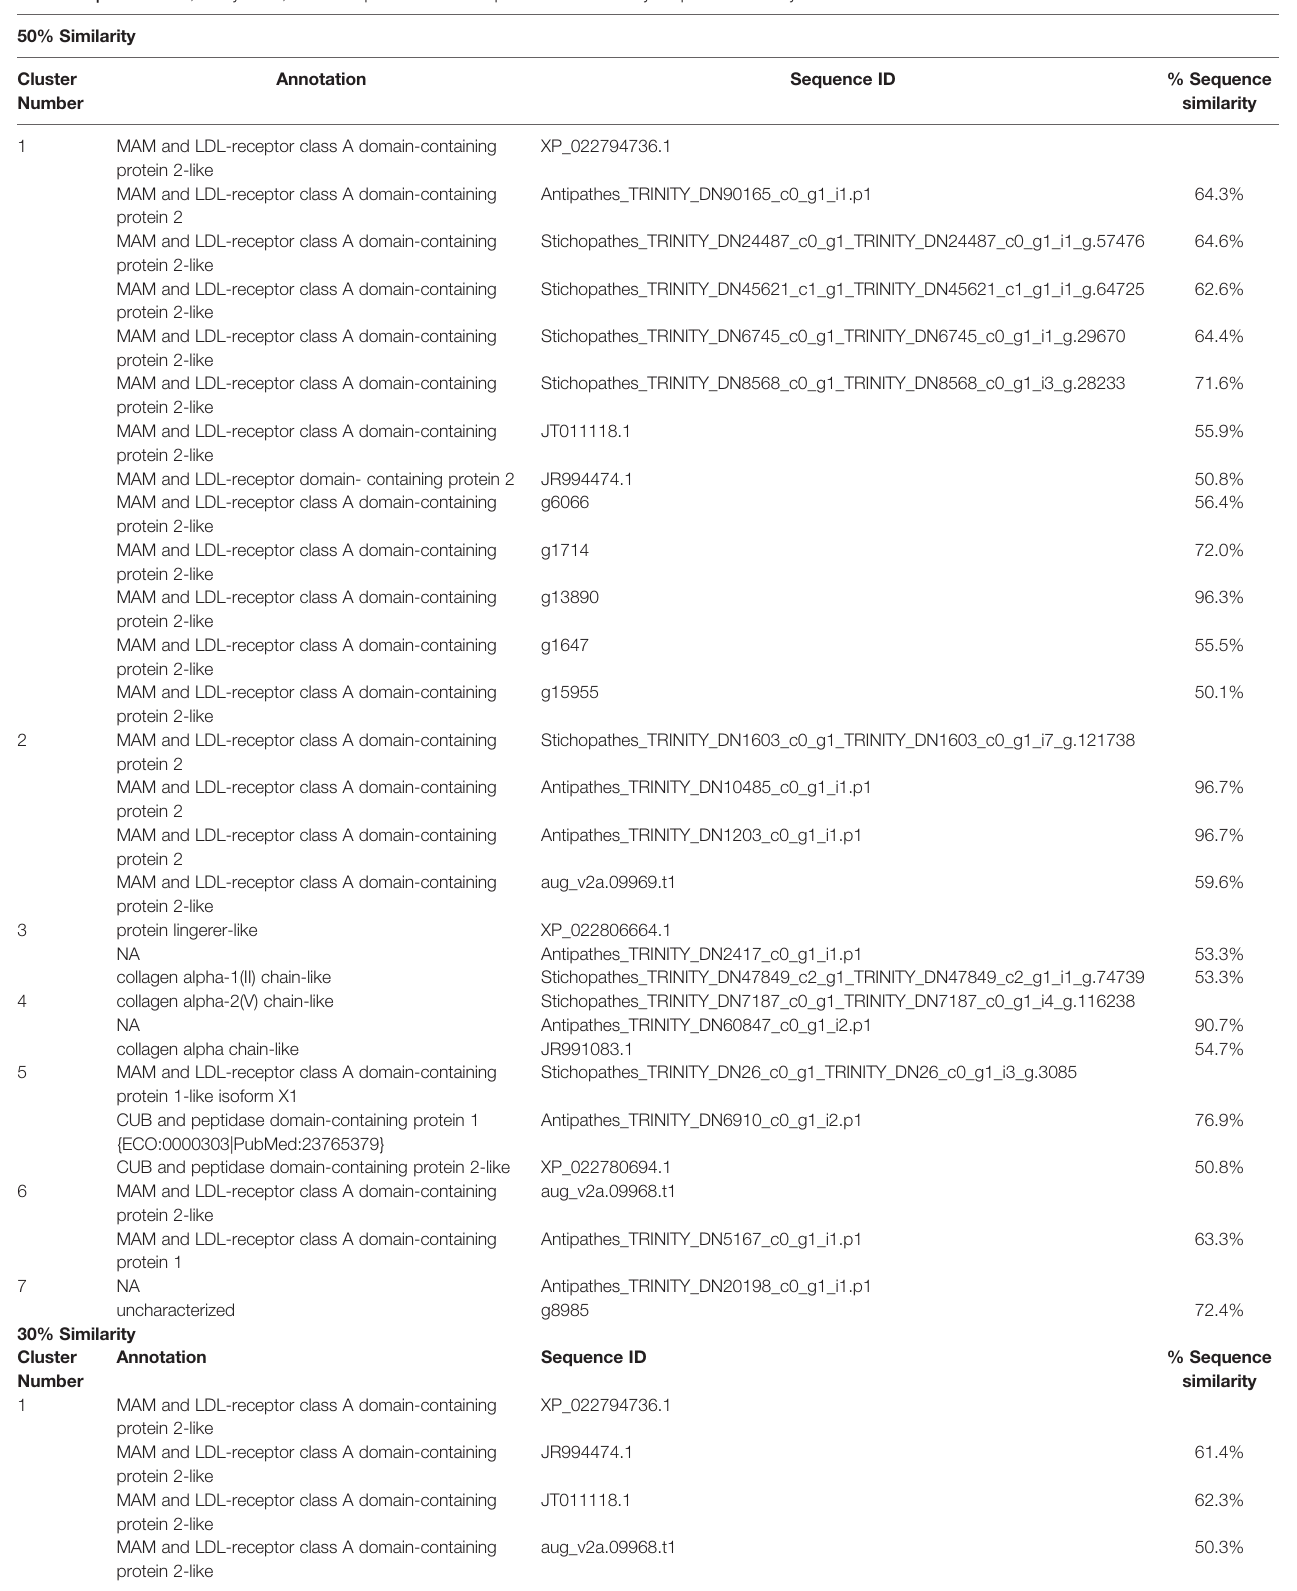
TABLE 1 | Black coral, stony coral, and mosquito exoskeleton proteins clustered by sequence similarity in